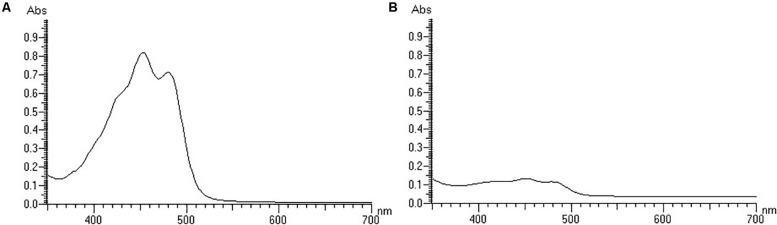
The UV–vis spectra of the carotenoid extracts of the strain YLOS41T under light (A) or dark (B) conditions.